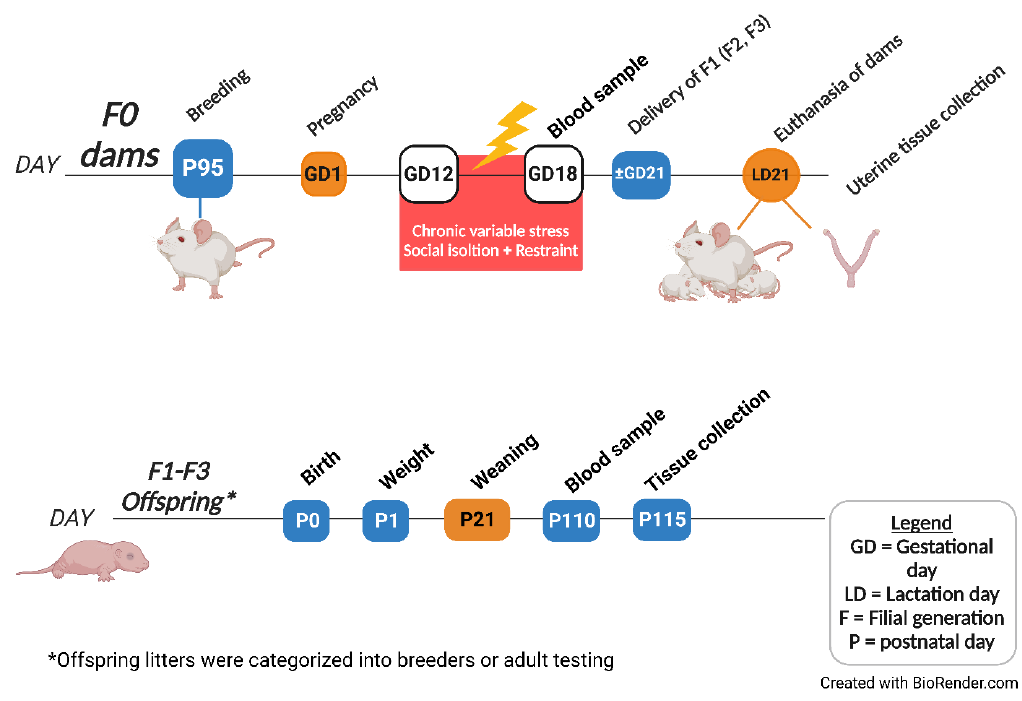
Figure 14. Timeline illustrating the stress protocol, tissue collection, and offspring analyses. Gestational stress was implemented from GD12 to GD18 using restraint and social isolation stressors, creating our psychological and psychosocial chronic variable stress (CVS) model. Blood collection occurred on GD18 in the mothers and on P110 in the offspring. Dams were sacrificed at the weaning of their offspring (LD21) when uterine tissues were collected. Tested offspring were euthanized and had their tissues collected on P115. Created with BioRender.com (accessed on 19 July 2022).